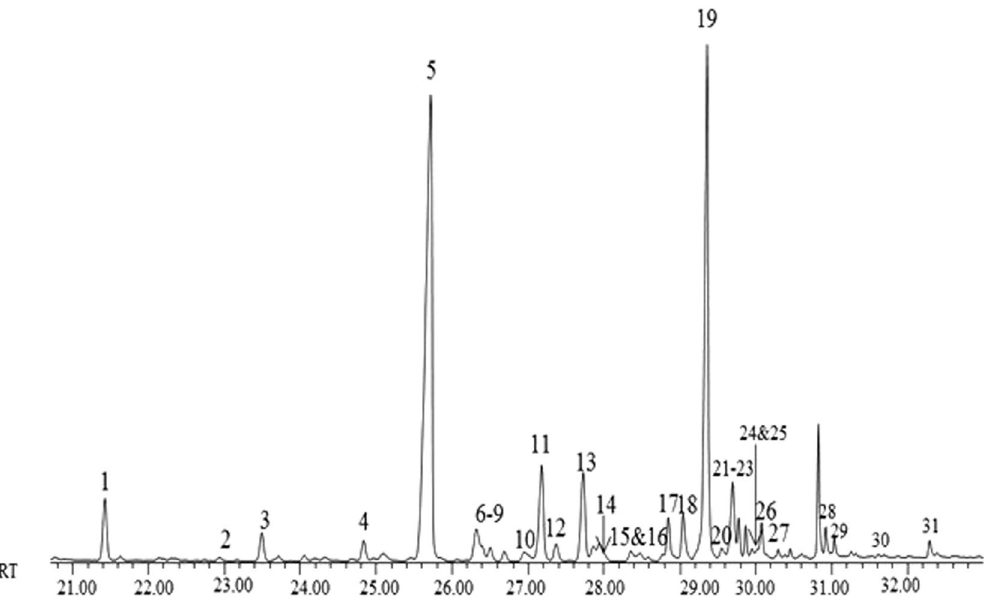
Figure 4. GC chromatogram of C . vicina puparial case extracted at week